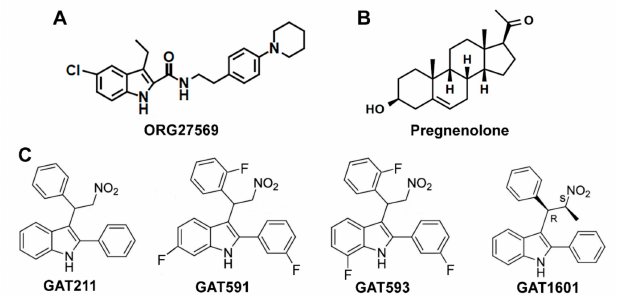
Figure 2. Biased allosteric ligands of CB1: ( A ) molecular structure of ORG27569; ( B ) molecular structure of pregnenolone; ( C ) molecular structures of GAT211 and its analogs, two fluorinated analogs—GAT591 and GAT593—and one methylated